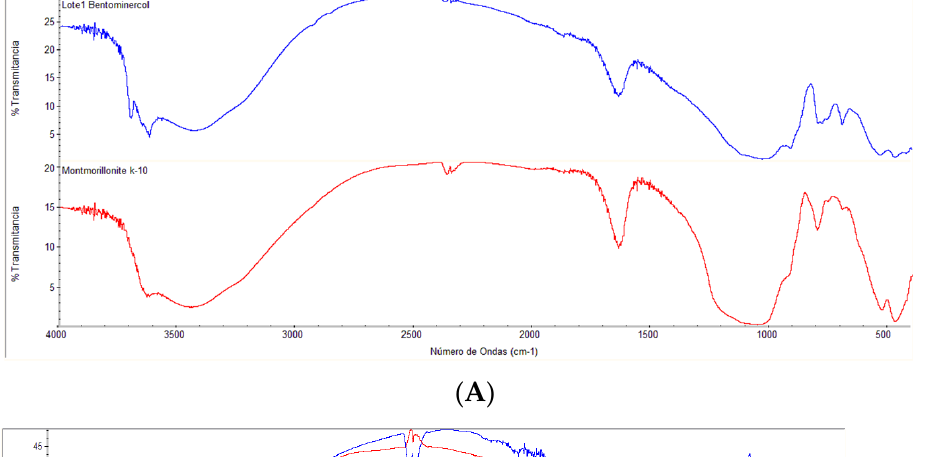
Figure 3. TGA analysis of purified raw bentonite clay.